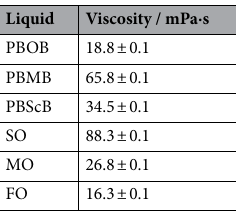
Table 1. Viscosity of the ionic liquids and oils at 100 °C. The uncertainty reported is the measurement uncertainty of the